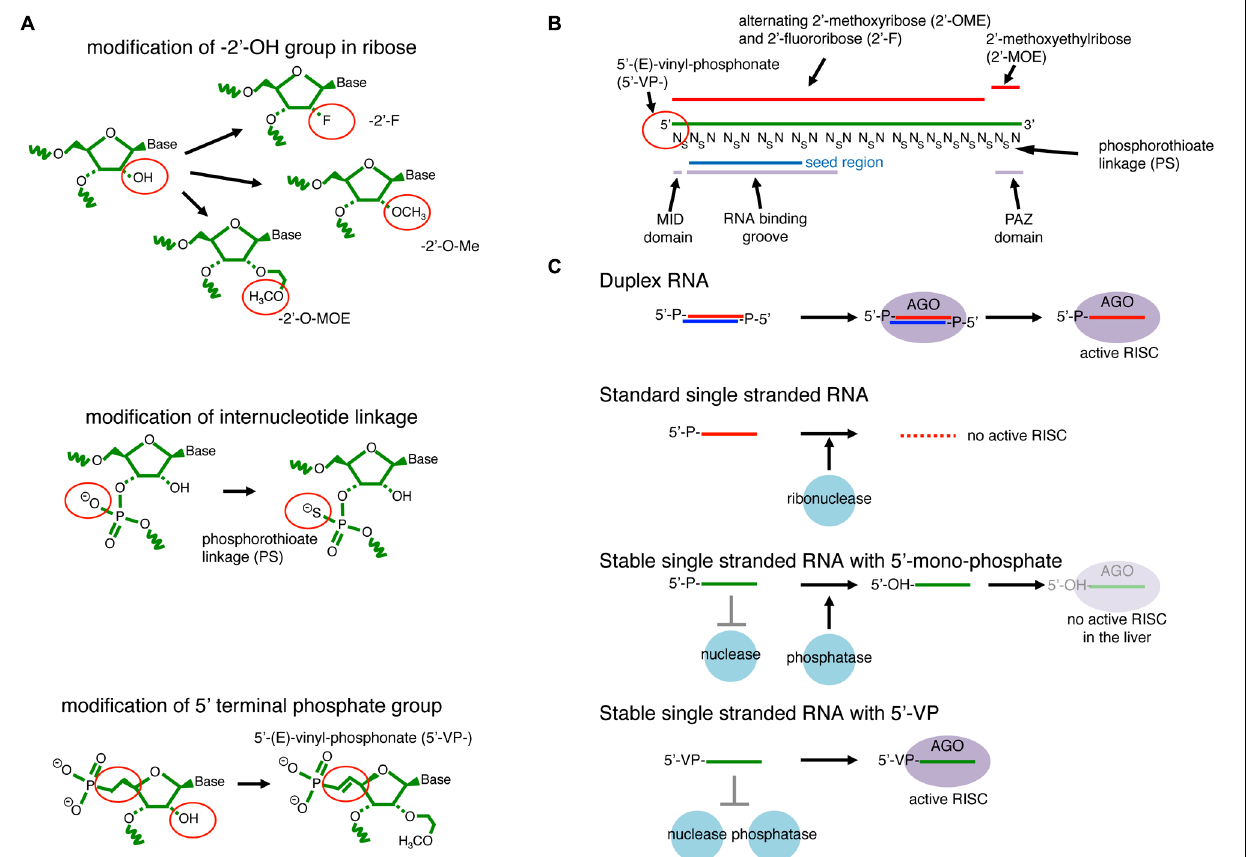
FIGURE 6 | RNAi with modified single-stranded- (ss-) siRNAs. (A) Examples of RNA modifications that stabilize ssRNAs. The 2 (cid:3) -OH group on ribose is modified to have 2 (cid:3) -fluoro (-2 (cid:3) -F), 2 (cid:3) - O -methyl (-2’O-Me), or 2 (cid:3) -methoxyethyl (-2 (cid:3) -MOE). The ss-RNA backbone contains either phosphodiester or phosphorothioate (PS) internucleotide linkages. (B) An example of effective ss-siRNA. The ss-siRNA used in Lima etal., (2012) contains 5 (cid:3) VP, 2 (cid:3) F, 2 (cid:3) - O -Me, and 2 (cid:3) -MOE modifications at specific positions. PS linkages are also introduced to all linkages between the first two nucleotides and last eight nucleotides, and also between every two nucleotides from the 3rd to 14th positions. The more stable 5 (cid:3) -( E )-vinylphosphonate (5’VP) share similar chemical properties to 5 (cid:3) -phosphate, which is essential for recognition by the Argonaute MID domain. The backbone of nucleotide position 2 to 10 runs along the